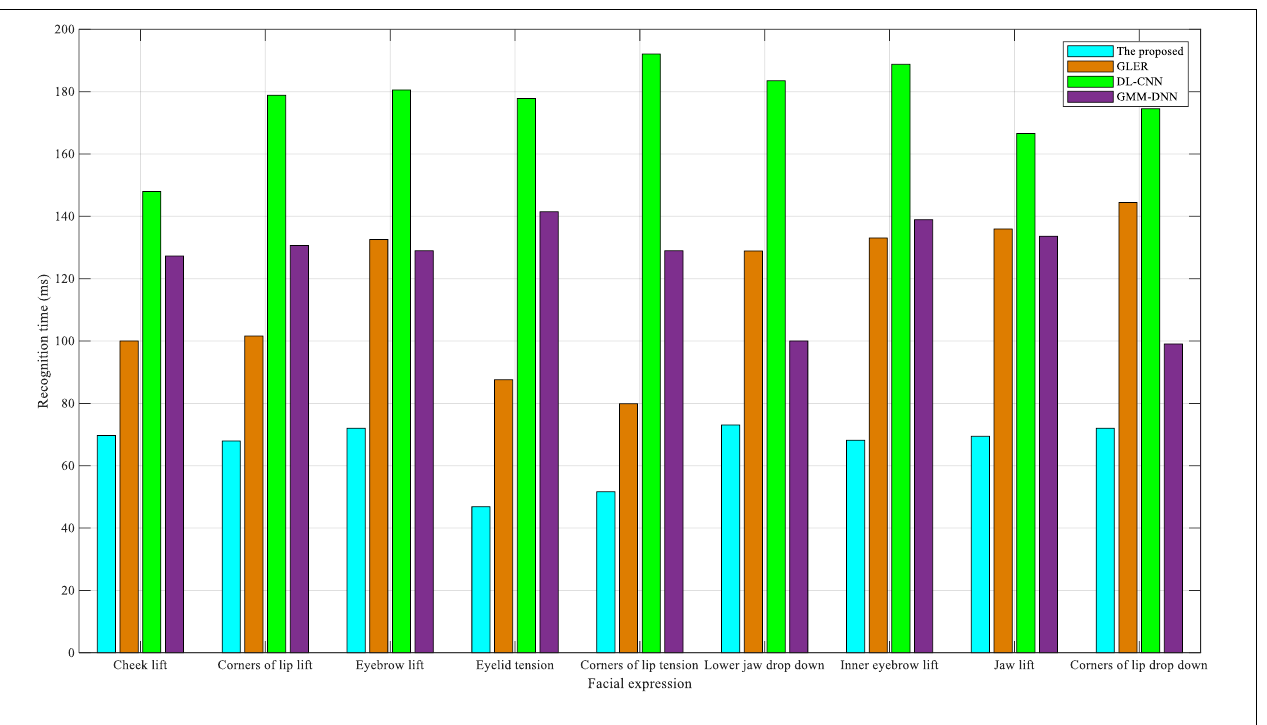
FIGURE 4 | Comparison of recognition time in eNTERFACE05